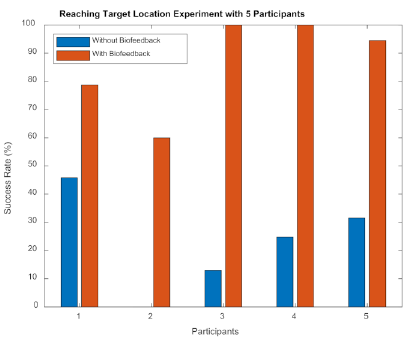
Figure 10. The success rate of reaching a target location experiment with 5